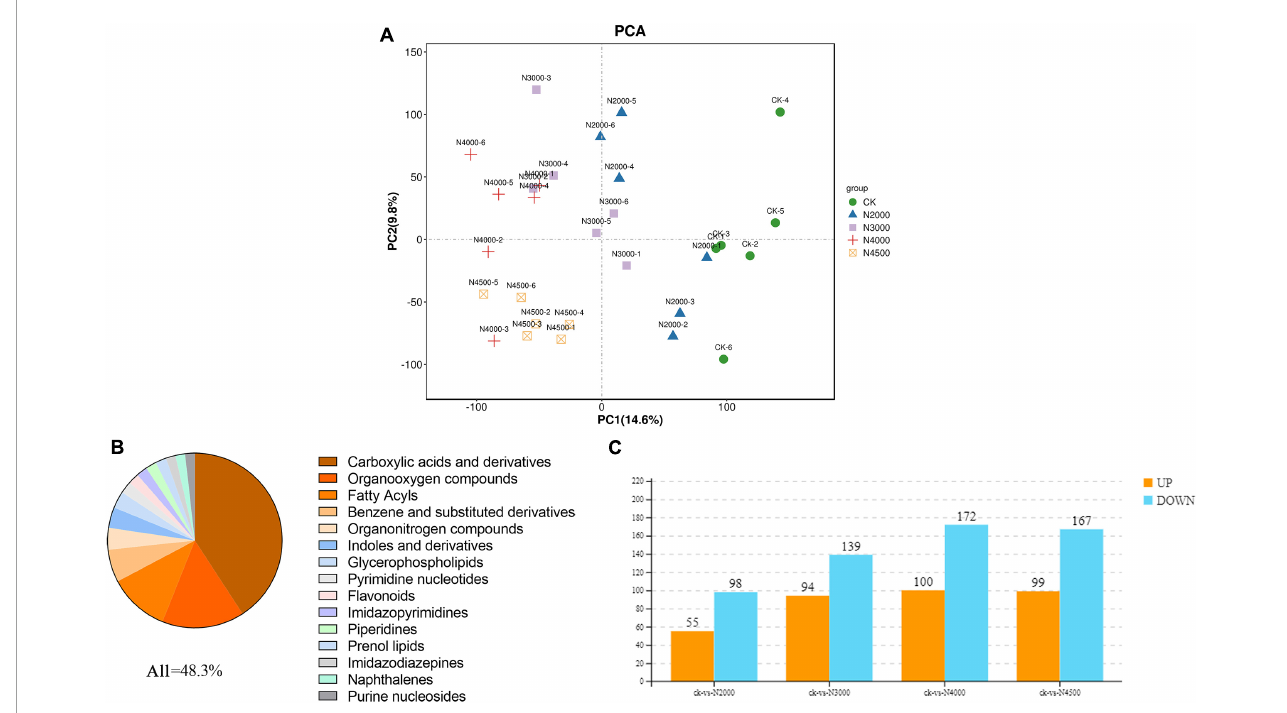
FIGURE5 The proportion of differentially abundant metabolites (DAMs) identified by the metabolome is shown in the figure for the top 15 metabolite categories. (A) PCA analysis of the control group and four samples with different concentrations (B) of differentially abundant metabolites (DAMs) identified by the metabolome is shown in the figure for the top 15 metabolite categories. (C) Histogram of different metabolites between control and different treatment